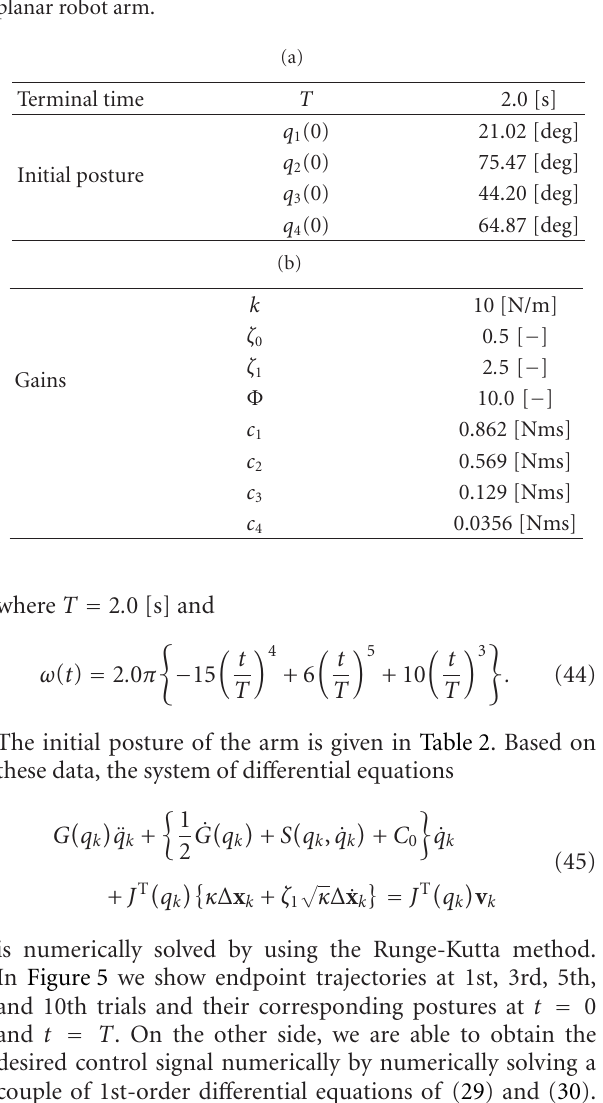
Table 2: Initial values and gain settings in the case of the 4-DOF planar robot